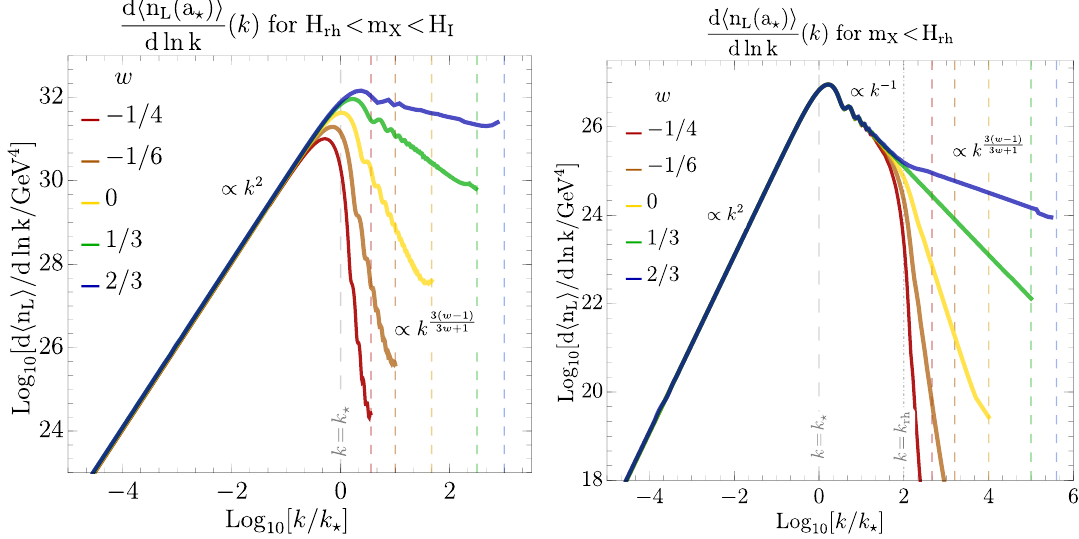
Figure 7 . Expectation value of the number density per ln k as a function of wavevector k at a = a ? for DM vector boson with mass in the range H rh (cid:20) m X < H I (left-panel) and m X < H rh (right-panel). Di(cid:11)erent colors correspond to di(cid:11)erent values of equation of state parameter w . Grey dashed (dotted) lines indicate k = k ? ( k rh ) while colored dashed lines refer to k = k e for corresponding value of w . For k < k ? the number density increases as k 2 , while for k ? < k < k e it is proportional to k 3( w (cid:0) 1) 1+3 w . Here we take H I = 10 13 GeV, (cid:13) = 10 (cid:0) 3 , m X = 10 8 GeV (left-panel), m X = 10 3 GeV